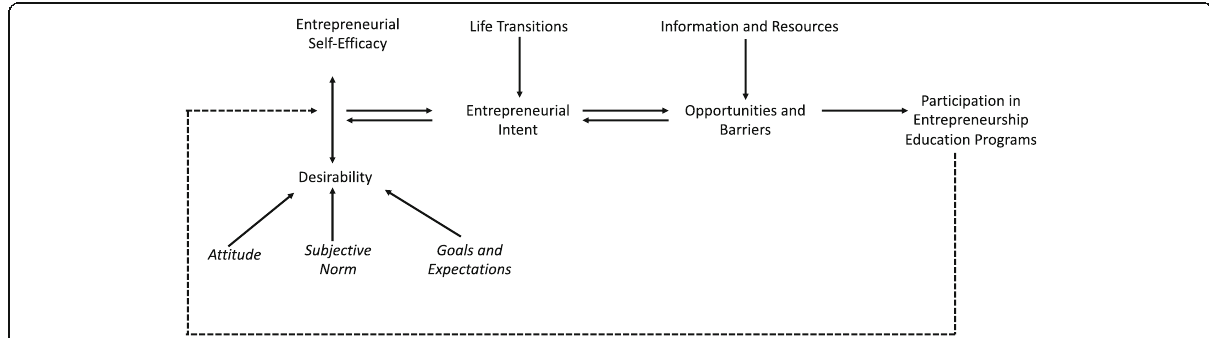
Fig. 1 Participation in Entrepreneurship Education Programs Model (Shekhar et al., 2018). [Note: Participation is both an outcome and influencing factor; thus, the closed loop nature of the figure represents the influence of participation in EEPs on future participation. The connecting arrows and their directionality serve as examples of plausible relationships between factors. However, our exploratory work focusses on unpacking the factors rather than imposing pre-conceived